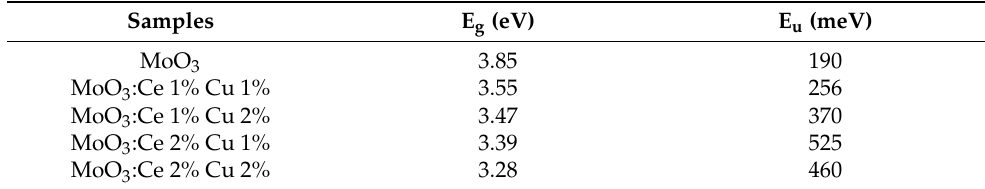
Figure 3. ( α h ν ) 2 vs. h ν for MoO 3 :Ce–Cu thin films. Table 3. Optical band gap Eg and Urbach energy for MoO 3 :Ce–Cu.